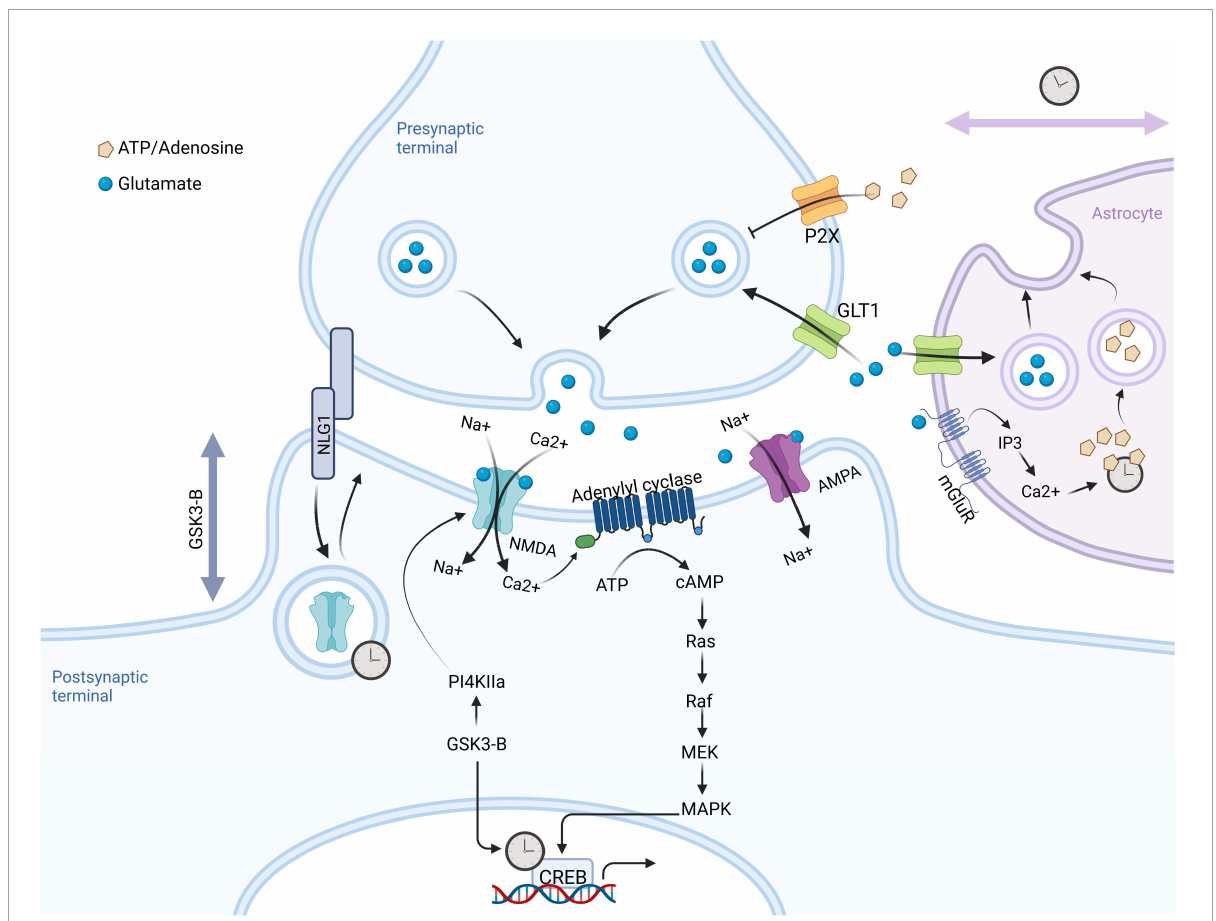
FIGURE3 Synaptic mechanisms under circadian control. Glutamate released from the presynaptic terminal binds to NMDA and AMPA receptors stimulating an influx of Na + and Ca 2 + , respectively. Ca 2 + - activated adenylyl cyclases lead to increased cAMP, ultimately resulting in CREB phosphorylation and activation of gene transcription. This pathway is both light-responsive in the SCN and under circadian control in the hippocampus, where it regulates learning and memory. Meanwhile the clock-controlled gene, GSK3 β , regulates post-synaptic dendritic growth. Astrocytes play an important role in circadian timing in the SCN, where their circadian nighttime activity suppresses activity of SCN neurons by regulation of extrasynaptic glutamate levels. Intracellular calcium levels in astrocytes are also highly dynamic over the 24-h